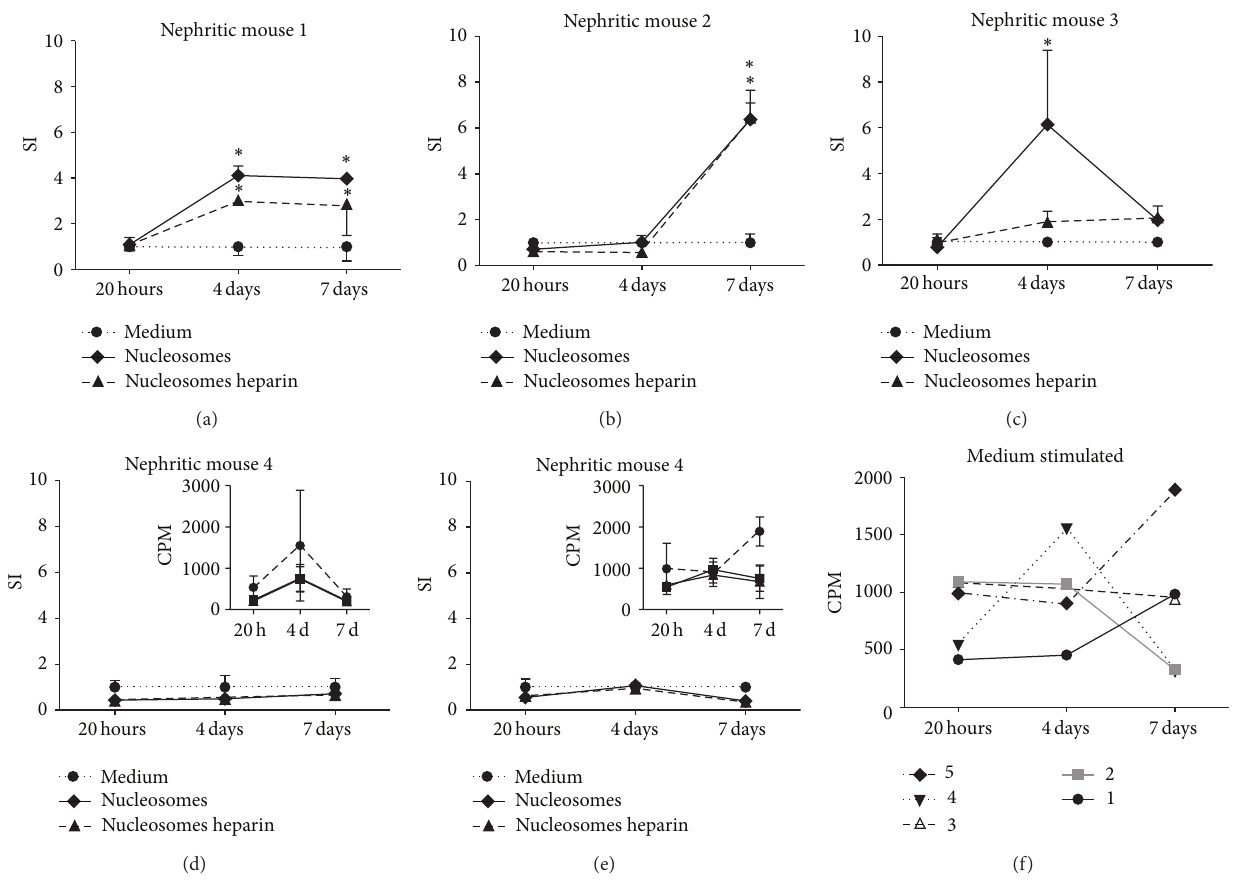
Figure 4: Splenocyte cell proliferation in response to nucleosomes. Splenocytes derived from three of the nephritic mice showed increased proliferation in response to nucleosomes; LMW heparin did not interfere with proliferation magnitude or kinetics ((a), (b), and (c), proliferation is shown as stimulation index (SI)). Apparently no proliferation was seen in cell cultures from two of the nephritic mice ((d), (e)), although responses in cpm indicate that the cells proliferate ((d), (e), inserted figures). Proliferations in medium for individual mice are shown as cpm (f). Mean values and SD were calculated from triplicates. ∗ Statistically significant ( 𝑃 < 0.05 ) compared to medium stimulated cells at the same time